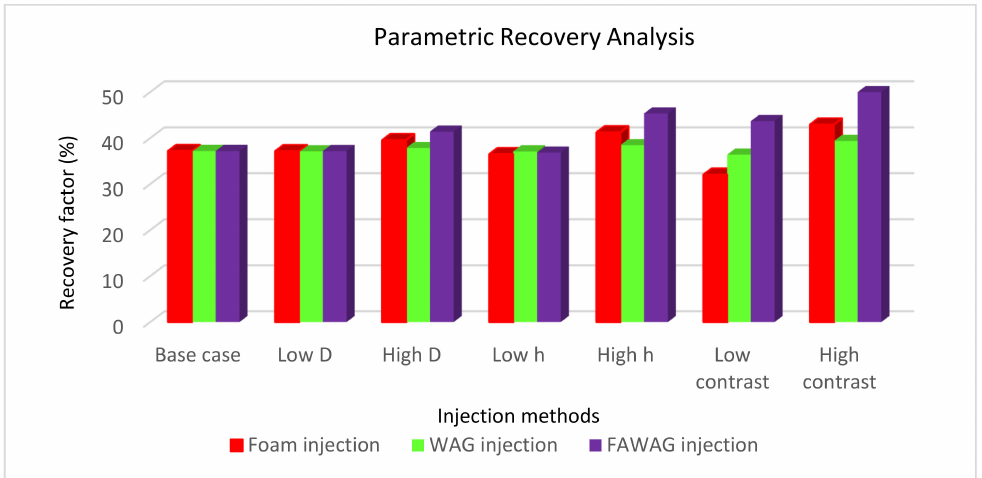
Figure 18. Comparison of oil recovery for foam (red), WAG (green), and FAWAG (purple) injection